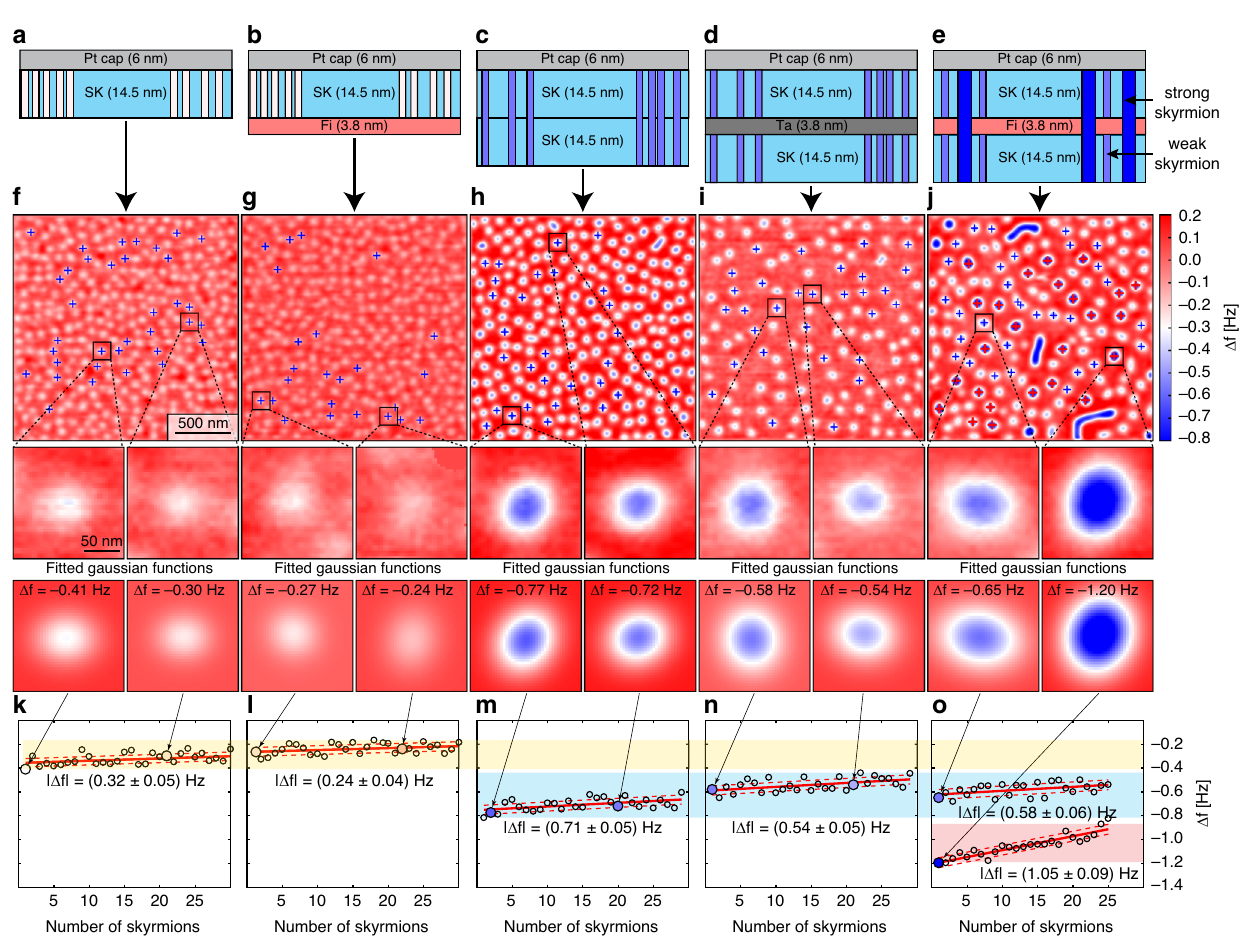
Fig. 2 Different samples used to disentangle the contributions to the measured magnetic force microscopy (MFM) contrast on the skyrmion/ ferrimagnet/skyrmion (SK/Fi/SK) sample. a A single 14.5-nm thick ferromagnetic layer (SK) is deposited directly on the Pt-seed (not shown) on top of the oxidized Si-wafer. The vertical, white rectangles schematically depict the skyrmions. b The same ferromagnetic layer as in a but deposited on the [(TbGd)(0.2)/Co(0.4)] ×6 /(TbGd)(0.2) ferrimagnetic layer. c A sample consisting of two 14.5-nm thick SK layers. d Similar to c but the two SK layers are separated by a magnetically inactive 3.8-nm thick Ta layer. The skyrmions within the two SK layers are depicted by the vertical pale blue rectangles. e Schematics of the trilayer sample consisting of two SK layers separated by a 3.8-nm thick Fi layer; the skyrmions are depicted by the vertical pale blue rectangles penetrating through the SK layer and by the wider dark blue rectangles for the strong contrast skyrmions penetrating through all layers. f – j 2 × 2 μ m MFM data (top row) and zoomed images of skyrmions shown together with the fi tted Gaussian functions (lower rows) obtained on each of the samples in a – e . The crosses in panels f – j highlight the skyrmions which have been fi tted to determine the frequency shift ( Δ f ) contrast displayed in panels k – o . All images have been taken in a fi eld of about 133 state 2 and its corresponding cross-sectional view are shown in Fig. 3e, f respectively, for D Fi = 0.8 mJ/m 2 . Differently from fi nal state 1, skyrmions exist in all sublayers of the bottom and top SK layers, and also in the Fi layer. Hence, a tubular skyrmion with a larger radius is stabilized. Interestingly, the skyrmion chirality is thickness dependent. In the bottom-most Fe/Co-sublayer of the bottom SK layer, a Néel skyrmion with a counter-clockwise chirality opposite to the one favored by a negative DMI is stabilized. This chirality leads to an improved magnetic fl ux closure and hence optimizes the magnetostatic energy. Layers B2 up to B4 have the clockwise chirality expected for the negative DMI of the SK layers 34 , whereas the skyrmion chiralities in B5 and Fi layers derive from the trade-off among negative DMI of the SK layer, positive D Fi and IEC. The skyrmion chirality in the Fi layer is intermediate between Néel outward and Bloch types, thus reminiscent to a counter-clockwise skyrmion expected for the positive D Fi 35 . The frustration arising from the negative DMI skyrmion obtained in layer B5, that compromises between